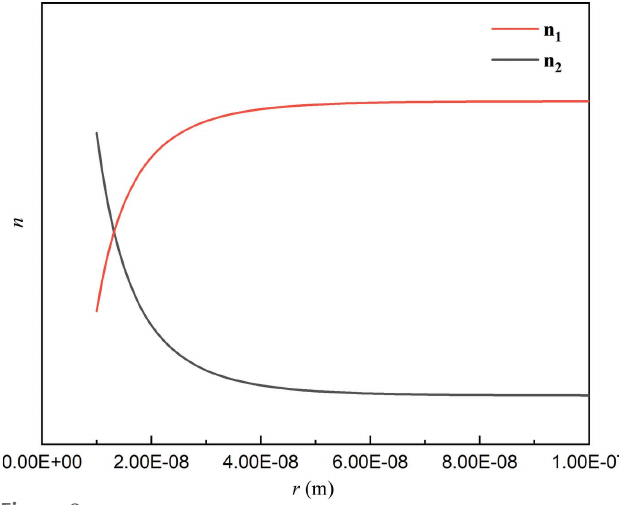
Spatial distribution of monomer density n 1 and dimer density n 2